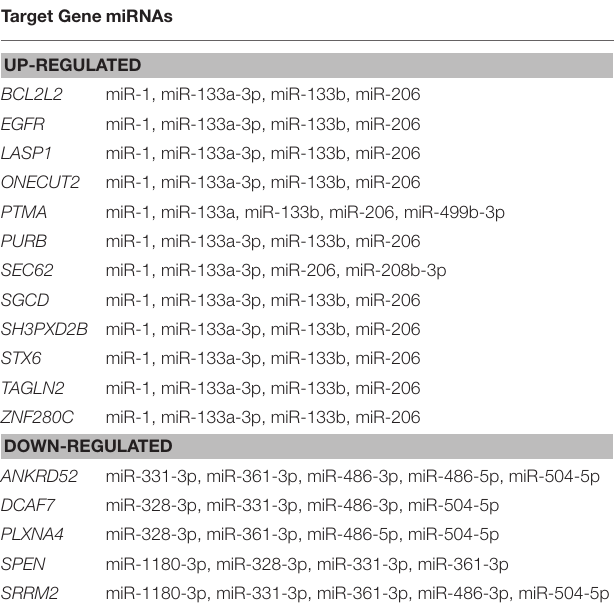
TABLE 5 | List of selected genes targeted by four or more up- or down-regulated miRNAs suitable for GO enrichment analysis. Target Gene miRNAs